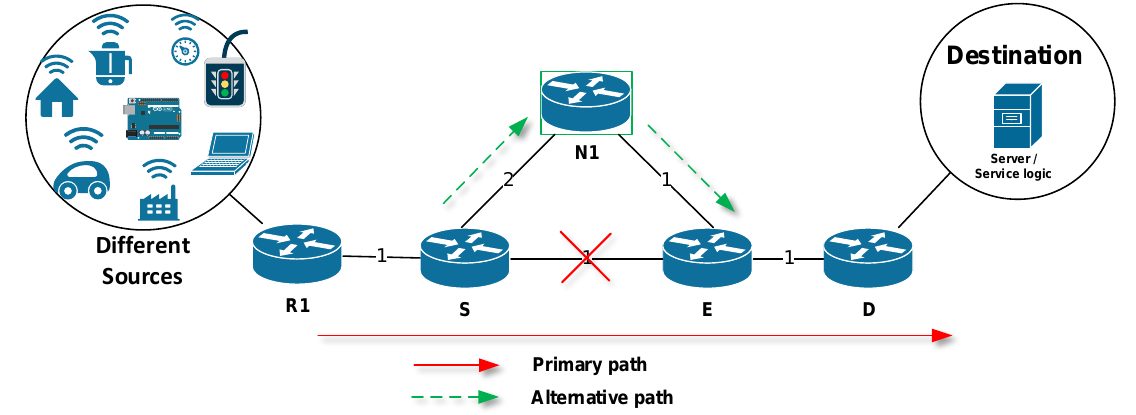
Figure 1. The principle of Fast ReRoute (FRR).